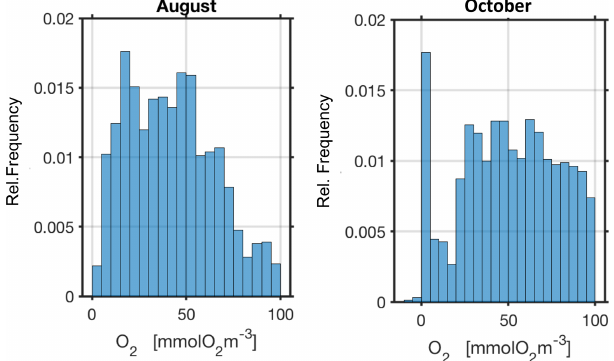
Figure 12. Histogram of observed climatological bottom oxygen concentrations at Boknis Eck (capped at 100mmolO 2 m − 3